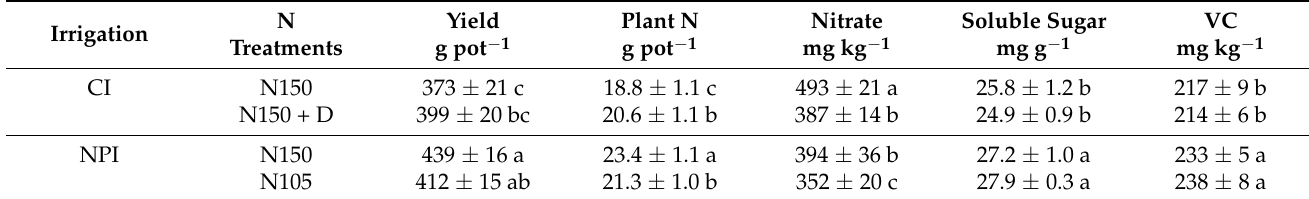
Table 2. Yield and quality of lettuce under different irrigation and N treatments in experiment 2.